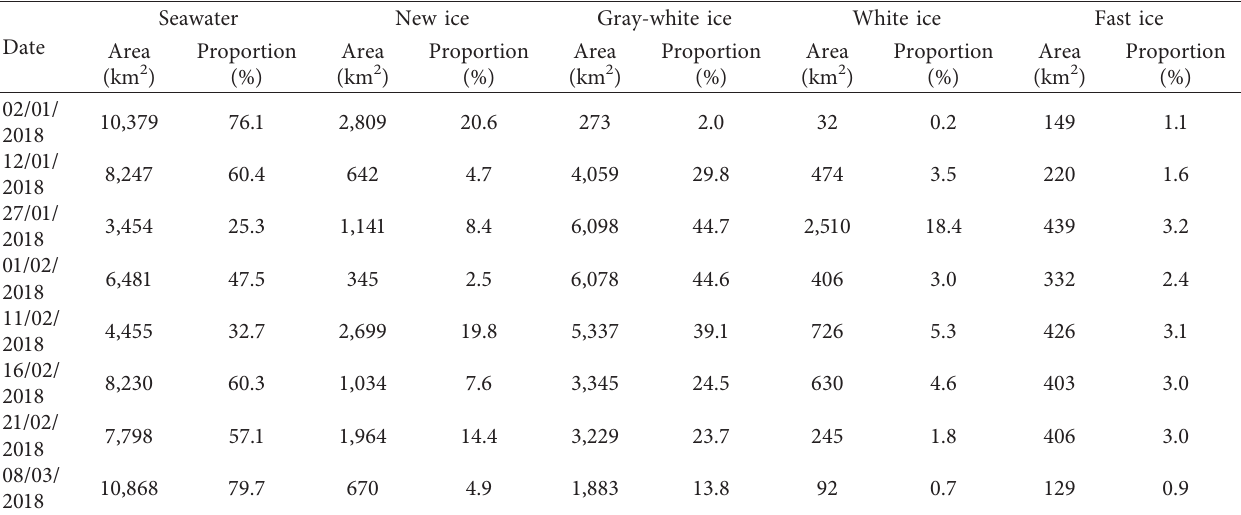
Table 4: Statistical analysis of the area and the proportion of various sea ice types in Liaodong Bay during the freezing period in 2017/2018.